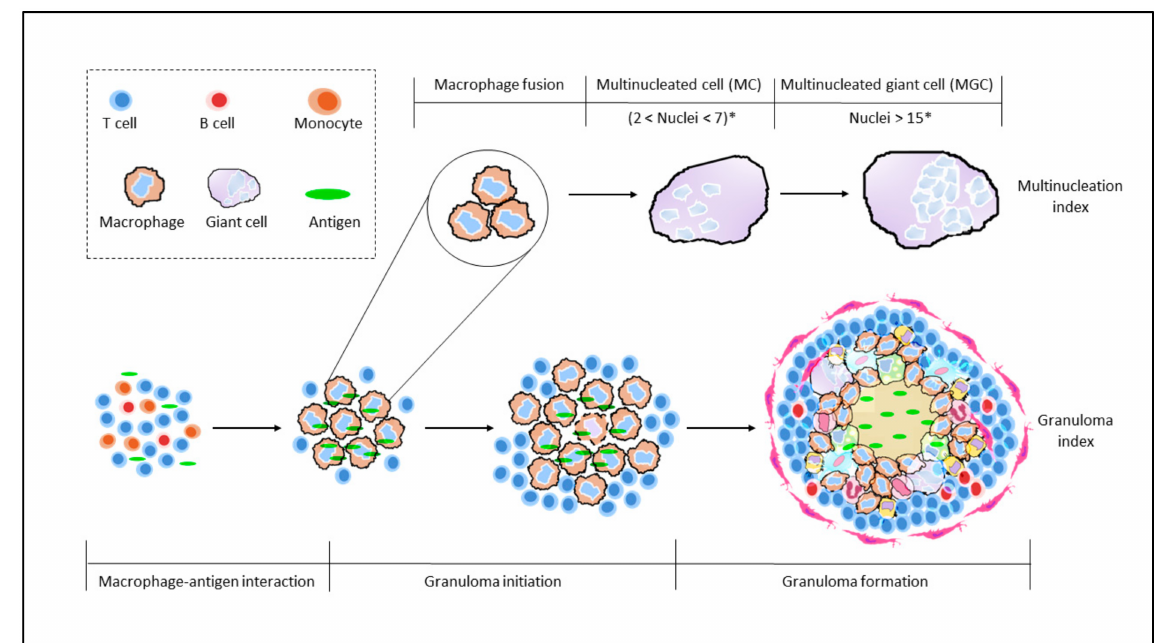
Figure 3. Comparing granuloma indices with maturation of giant cells. Staging of granuloma development is currently still being explored with the already established granuloma indices, GI-B and GI-S. Both GI, however, still lack consideration for monocytes/macrophage maturation. This is countered by the Multinucleation index, wherein an increasing nuclei count is an indication of maturation of macrophages towards the formation of MGC. A combination of these two indices would prove to be more inclusive and well-rounded. * number of nuclei observed would vary, depending on length of